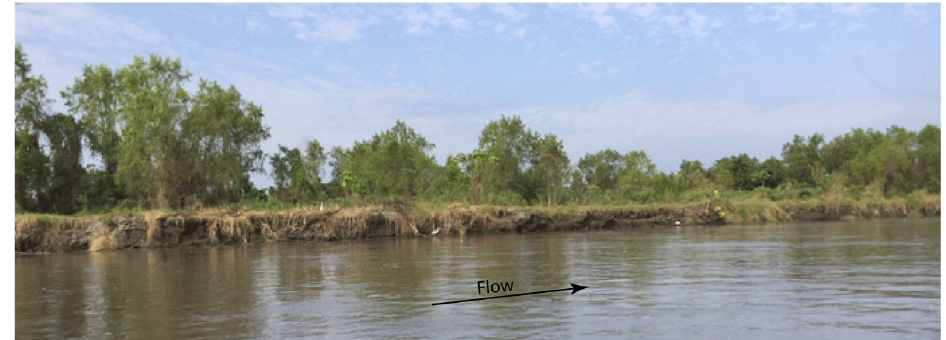
Figure 12. A channel of the Magdalena River close to Barrancabermeja. The land visible here is a macro island vegetated. Along the banks separating the channels from the floodplain, it is common to find dense, tall vegetation (trees); frequent woody debris are indeed present within the channels, often partly or fully buried by sediments.